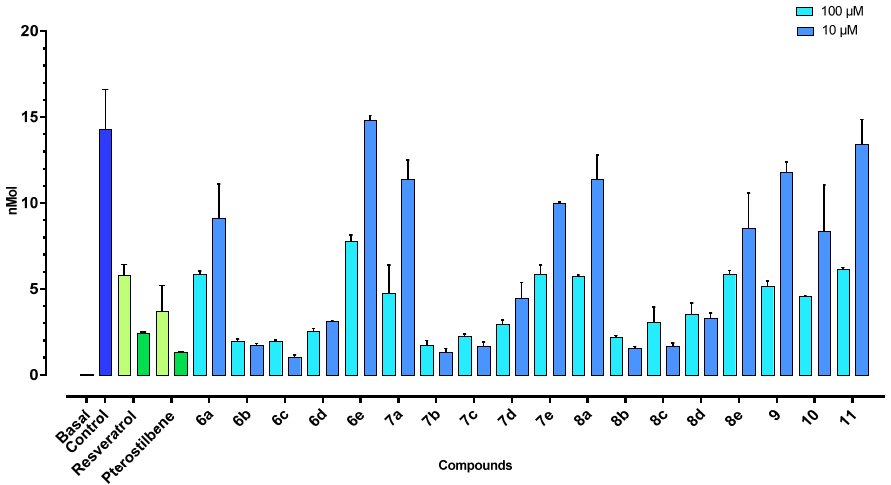
Figure 2. Effects of ( E )-benzaldehyde O -benzyl oximes 6a–e , 7a–e , 8a–e , and 9–11 , resveratrol, and pterostilbene on the production of thiobarbituric acid reactive substances (TBARS) in rat brain ho- mogenate.